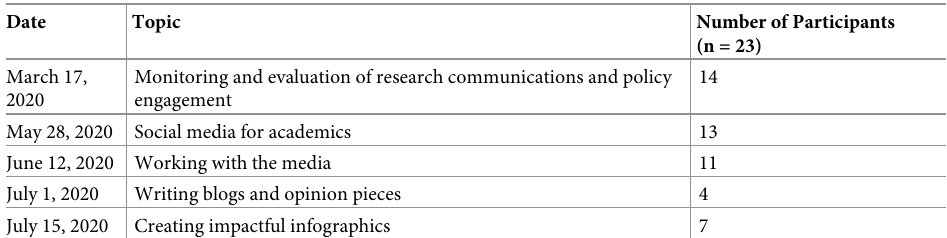
Table 4. Webinar topics and